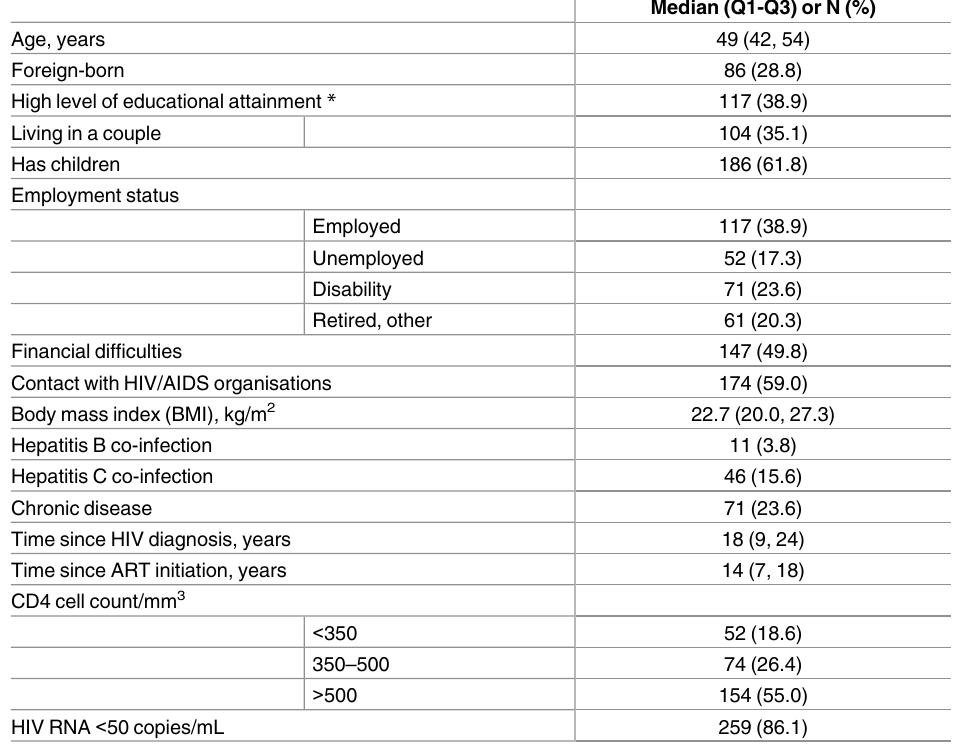
Table 1. Sociodemographic and clinical characteristics of the 301 women living with HIV who partici- pated in the EVE study